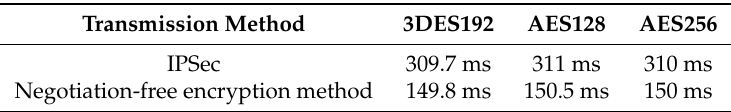
Table 4. Average